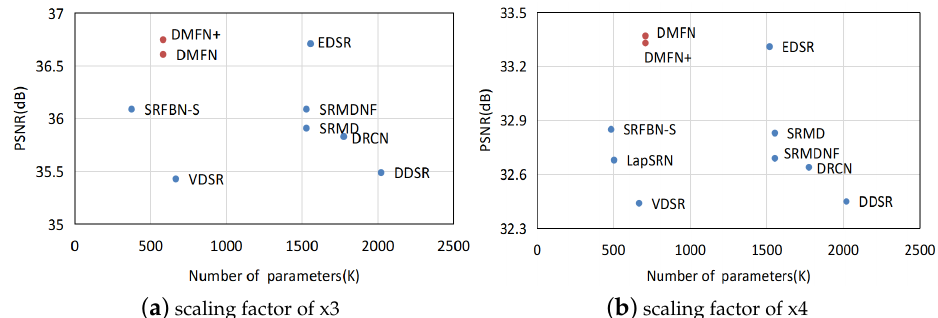
Figure 1. The structure of DMFN.